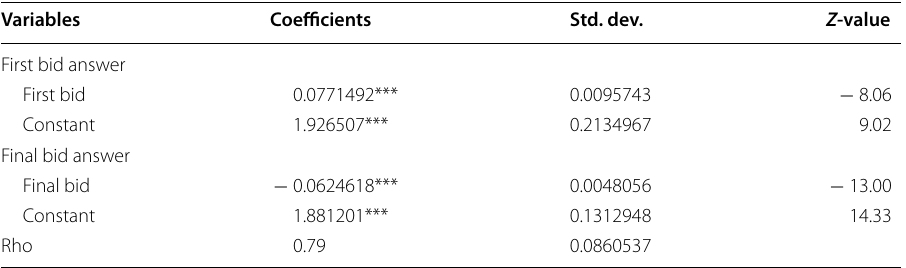
Table 4 Seemingly unrelated bivariate probit model estimated results. Source: Author’s estimation,